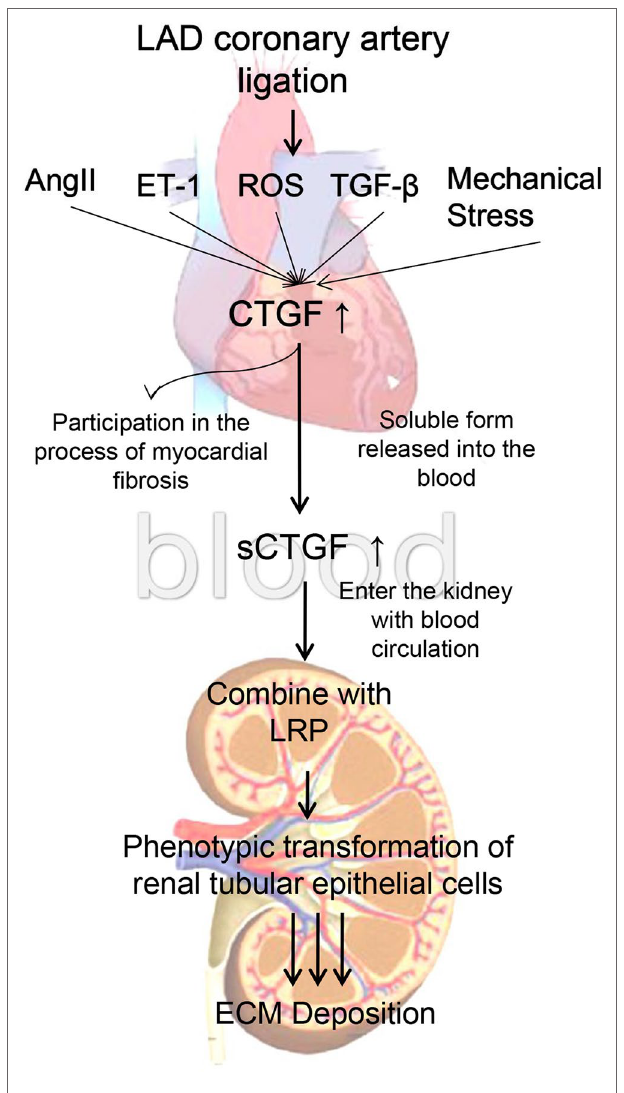
FIGURE 9 | Mechanism of cardiac-renal connection. LAD, left anterior descending. AngII, angiotensin II. ET-1, endothelin 1. ROS, reactive oxygen species. TGF- β , transforming growth factor- β . CTGF, connective tissue growth factor. sCTGF, soluble form CTGF. LRP, low-density lipoprotein receptor-related protein. ECM, extracellular